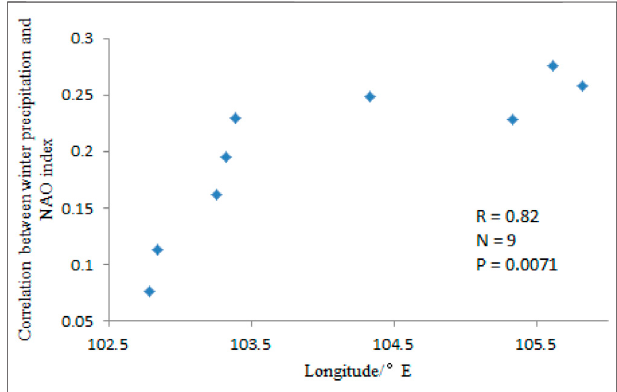
FIGURE 6 | Relationship between longitude and R in 23 ° – 24 ° N (R: Correlation between winter precipitation and NAO index).